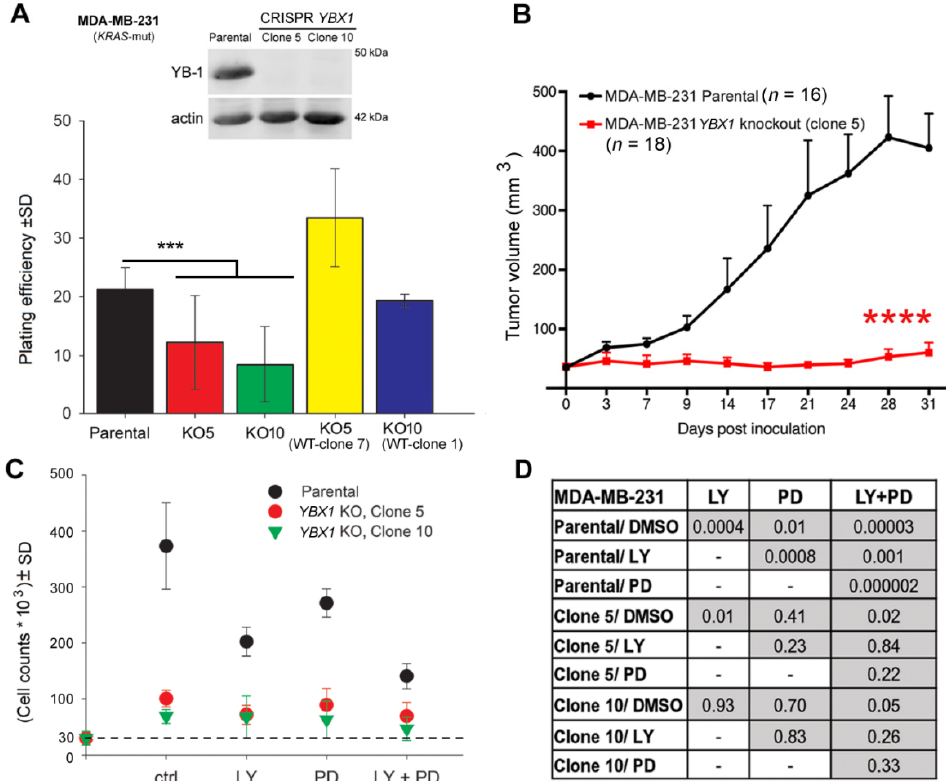
Figure 1. YBX1 knockout hampers clonogenic activity, inhibits tumor growth, and abrogates the anti-proliferative e ff ect of PI3K and MEK inhibitors. ( A ) The clonogenic activity of the indicated cells with di ff erential YB-1 status, i.e., MDA-MB-231 parental cell, YBX1 knockout clones 5 and 10, YBX1 knockout clone 5 after reconstitution of WT YB-1 clone 7 (KO5-WT-Clone 7), and YBX1